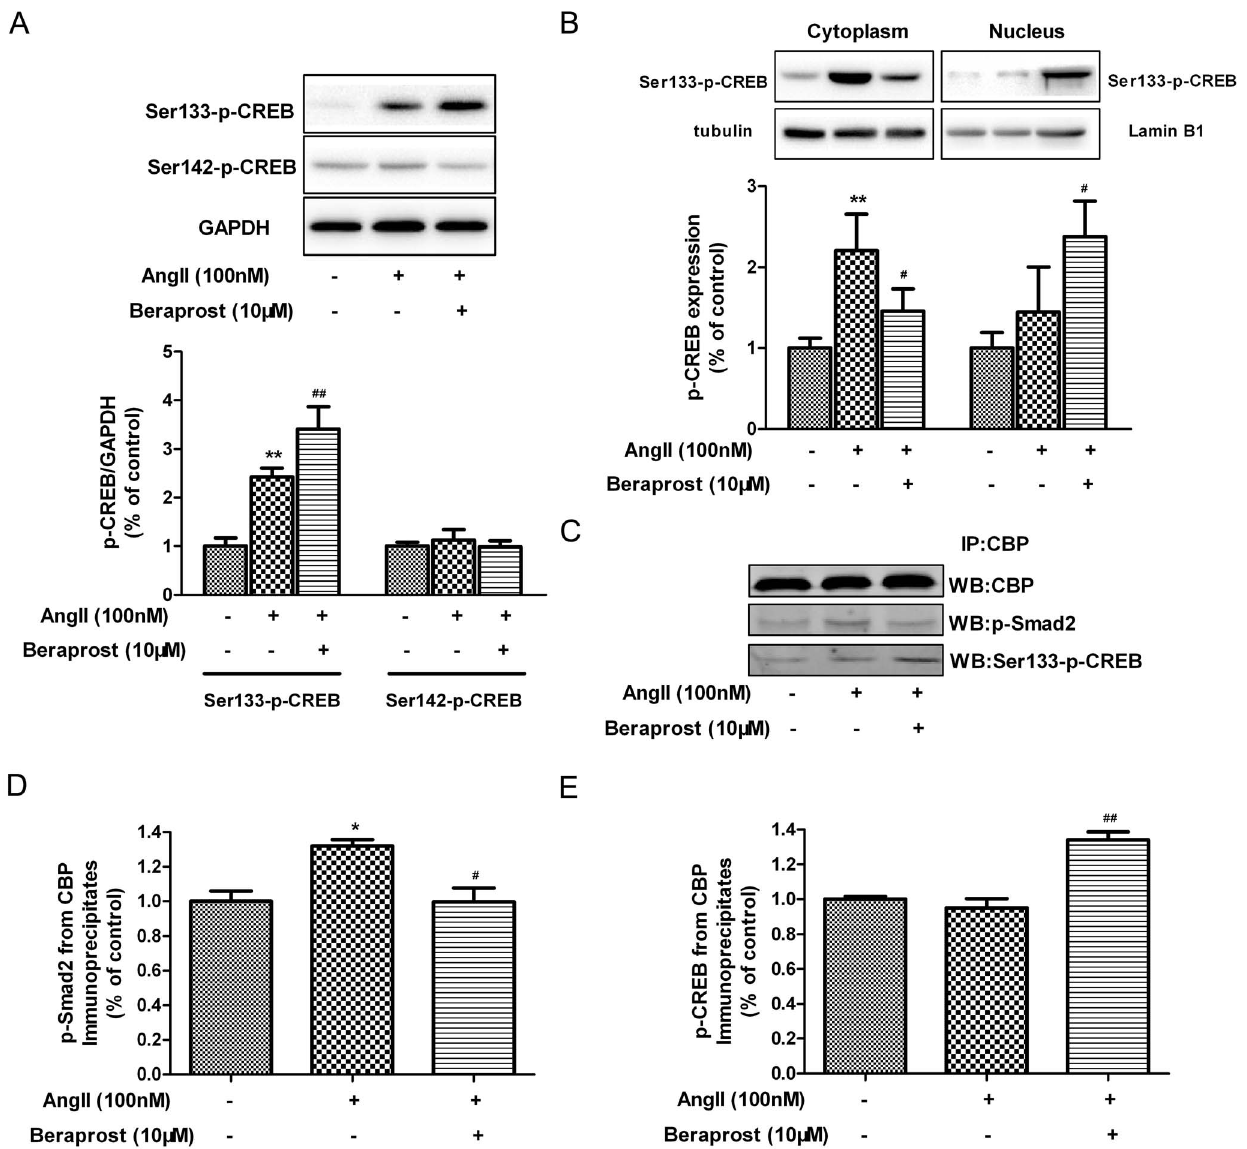
Figure 8. Beraprost regulated CREB phosphorylation and nuclear translocation in Ang II-induced cardiac fibroblasts. Neonatal rat cardiac fibroblasts were pre-treated with beraprost (10 m M) for 4 h followed by Ang II (100 nM) stimulation for an additional 24 h. (A) Cell lysates were tested for phosphorylation of CREB at Ser133 and Ser142 by western blot. (B) Proteins from cytoplasm and nucleus respectively were tested for phosphorylation of CREB at Ser133 by western blot. (C) Nuclear proteins were immunoprecipitated with anti-CBP antibody. The precipitated proteins were analyzed with western blots using anti-Smad2 or Ser133-p-CREB antibodies. The total CBP detected with the anti-CBP antibody was used to normalize the signals. (D) Quantitative analysis of p-Smad2-CBP association. (E) Quantitative analysis of p-CREB-CBP association. Values are expressed as mean 6 SEM. Cells treated with culture medium served as a vehicle control (con), * P , 0.05, ** P , 0.01, compared with con, # P , 0.05, ## P , 0.01, compared with only Ang II stimulated group. n=4.